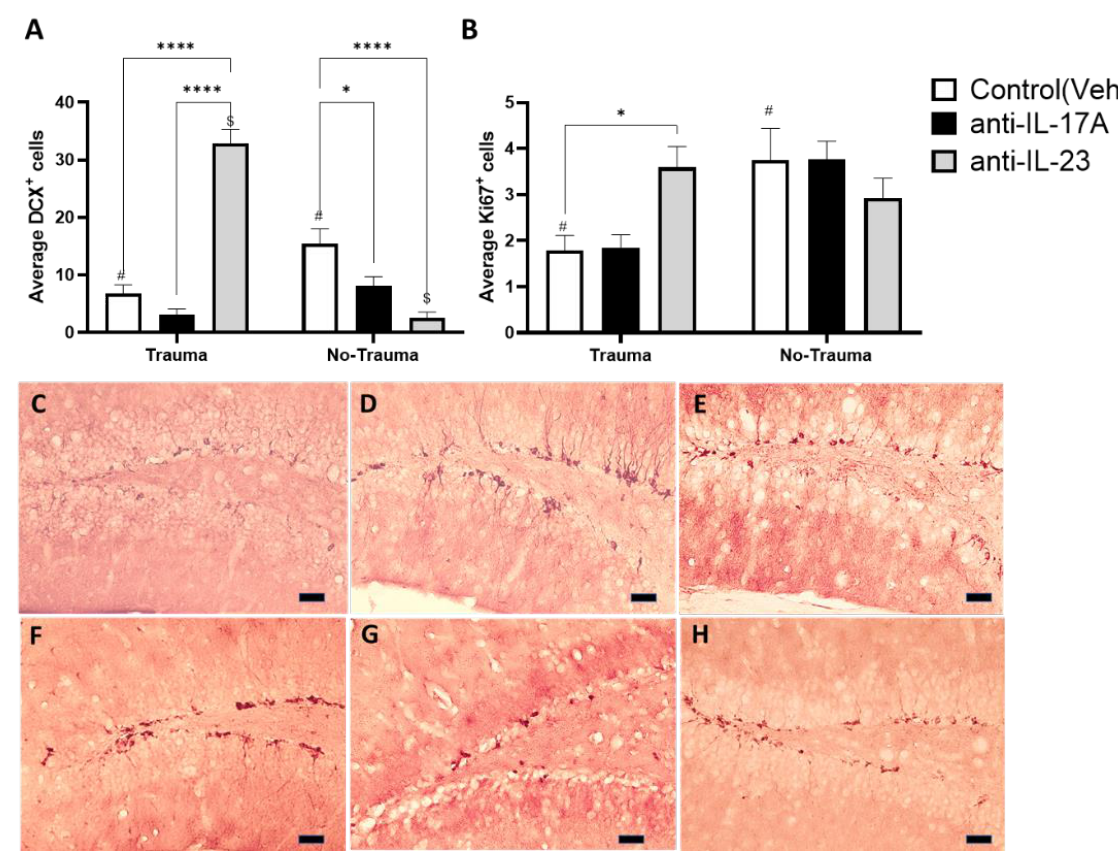
Figure 3. Exposure to trauma and antibody treatment affect hippocampal neurogenesis. Hippocampal neurogenesis was assessed by immunohistochemistry for proliferating neuro-progenitors (Ki67) and early differentiating neurons (DCX). ( A ) A graph presenting the average number of positive Ki67 cells in the sub-granular zone per hippocampal slide. (Trauma: anti-IL-17A, n = 5. anti-IL-23, n = 5, Control, n = 10. No trauma: anti-IL-17A, n = 3. anti-IL-23, n = 5, Control, n = 12). ( B ) A graph presenting the average number of positive DCX cells in the granular cell layer per hippocampal slide. Representing micrographs of DCX- stained hippocampi from trauma exposed mice treated with anti-IL-17A ( C ), anti-IL-23 ( D ), control (vehicle) ( E ) and control (no trauma) mice treated anti-IL-17A ( F ), anti-IL-23 ( G ) and control (vehicle) ( H ). All data in the graphs is presented as mean ± SE. * p < 0.05, **** p < 0.0001. Paired symbols represent statistical significance between the two corresponding groups: $ p < 0.05, # p < 0.05. Scale bars represent 20 µ m.